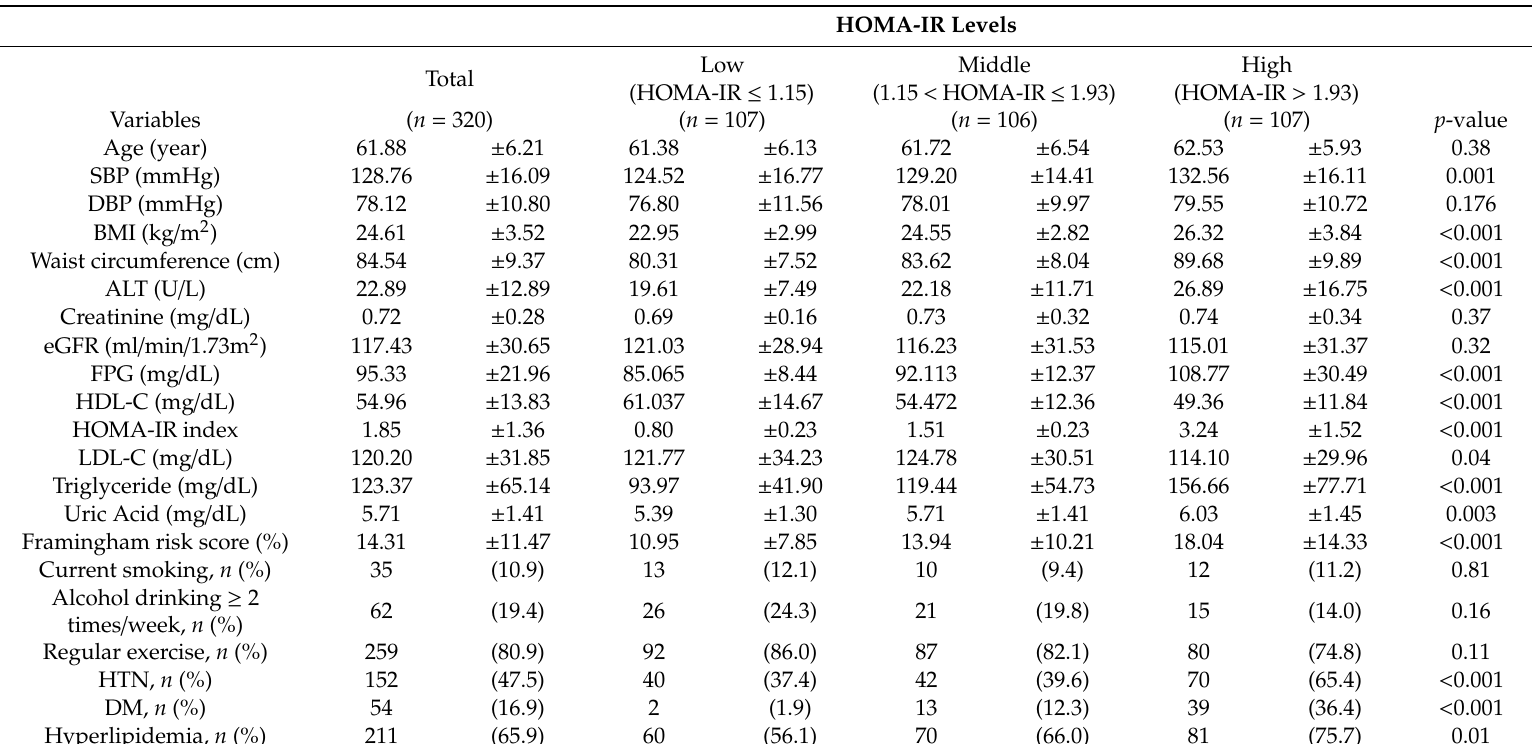
Table 1. General characteristics of the study population according to the tertiles of the HOMA-IR